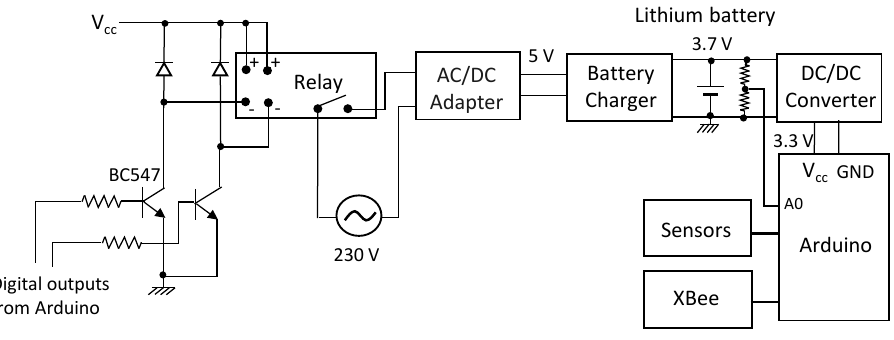
Figure 3. Power supply circuit.